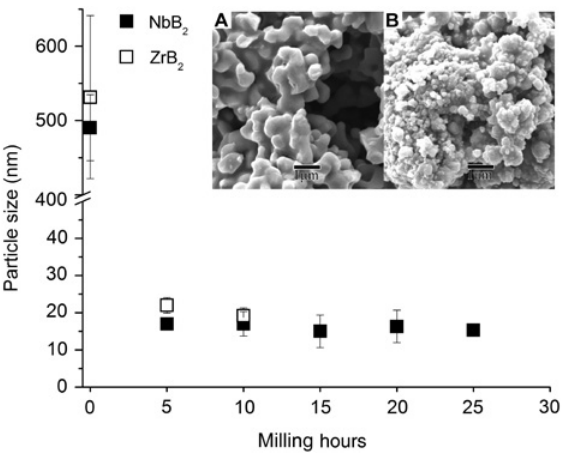
and ZrB particle size as a 2 2 particles: (A) as-received NbB (without 2 2 particles after 10 milling 2